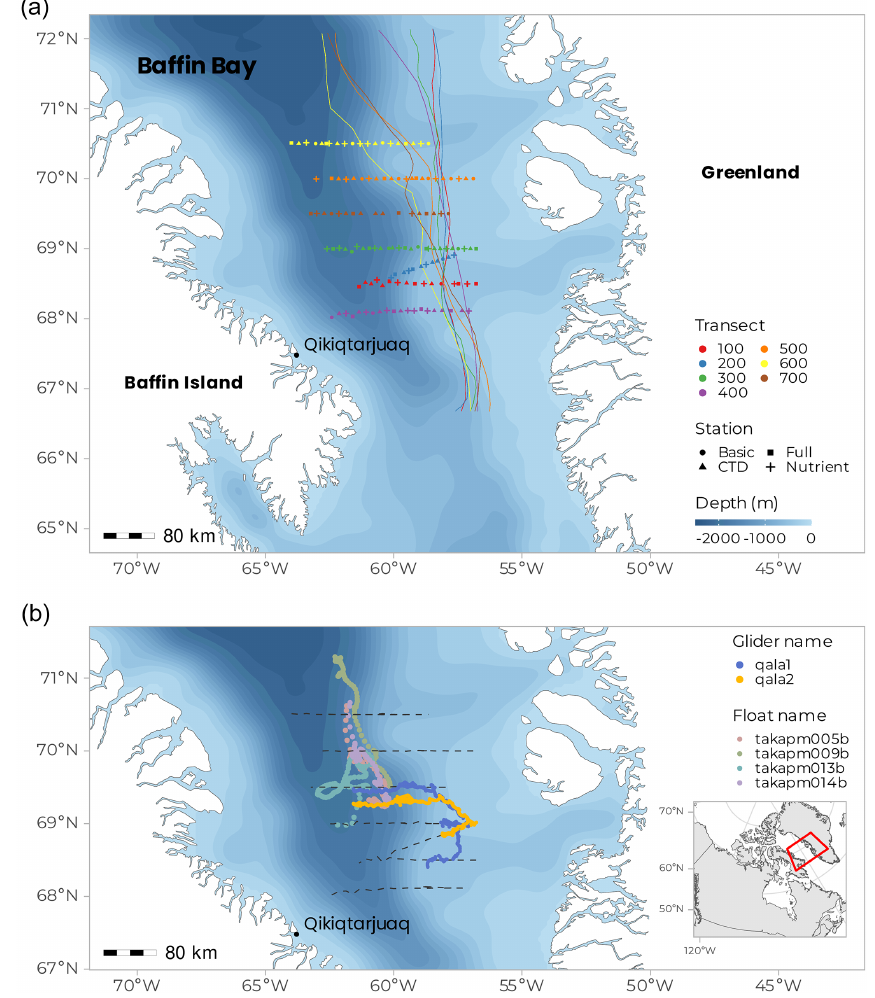
Figure 1. Cruise maps showing (a) the seven transects and all stations with shape distinction between station type (FULL, BASIC, NUT, and CTD, see Table 1 for description). Coloured lines indicate the position of the ice edge (sea-ice concentration at 80%) on each transect at the date of sampling; ice cover persisted on the western side of Baffin Bay, while the eastern side cleared earlier. The starting date of each transect sampling is as follows: 9 June (100), 14 June (200), 17 June (300), 24 June (400), 29 June (500), 3 July (600), and 7 July (700). (b) Tracks of the four BGC-Argo floats deployed during the Green Edge cruise over their first 101d of life, and the journey of the two SLOCUM gliders (blue and orange). The dashed line represents the ship track along the seven transects.